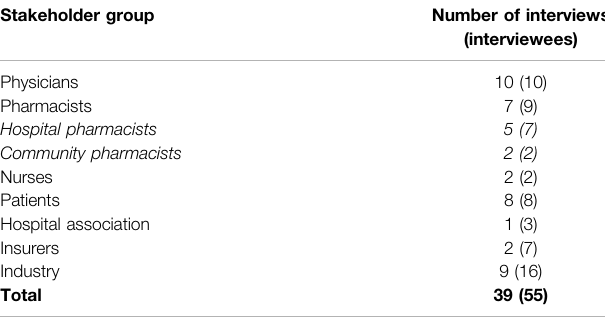
TABLE 1 | Overview of the number of interviews per stakeholder group. The total number of participants is mentioned between brackets. Stakeholder